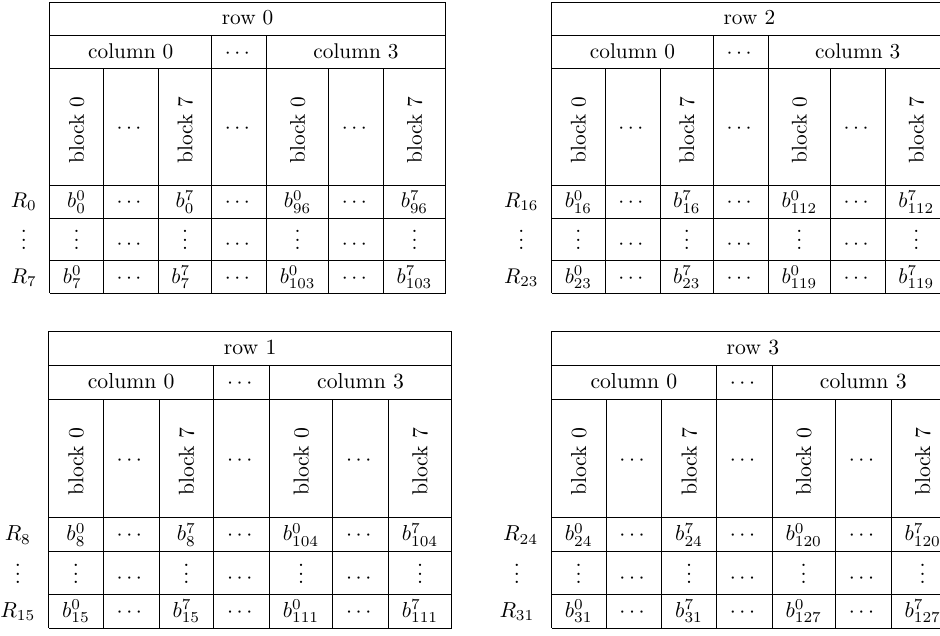
Figure 5: Barrel-shiftrows representation using 32 32-bit registers R 0 , · · · , R 31 to process 8 blocks b 0 , · · · , b 7 in parallel where b i refers to the i -th bit of the j -th j